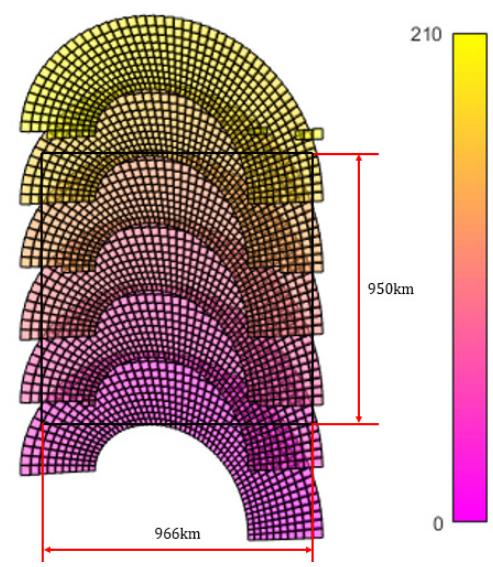
Figure 22. D ual-camera variable speed OCPSI mode: exposure time. Figure 22. Dual-camera variable speed OCPSI mode: exposure time.